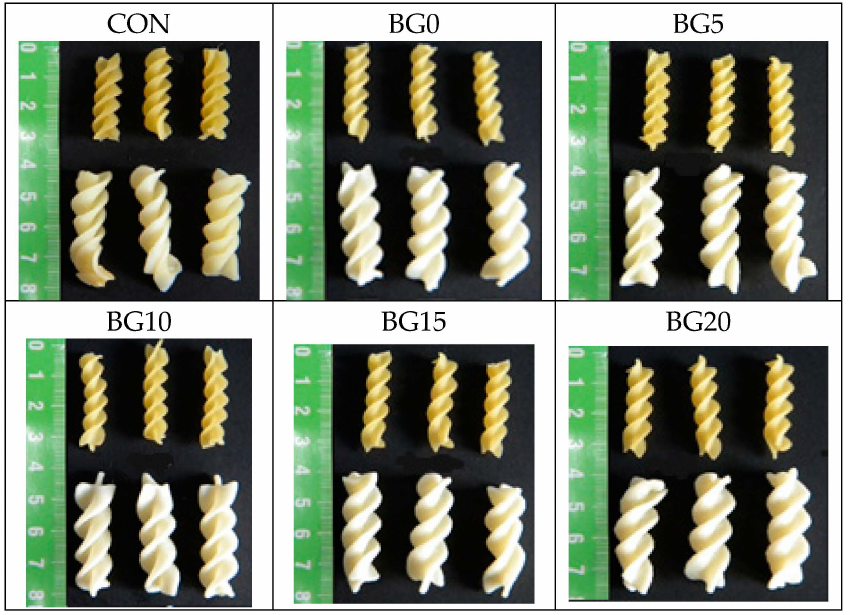
Figure 1. Uncooked and cooked pasta samples. CON—control sample; BG— β